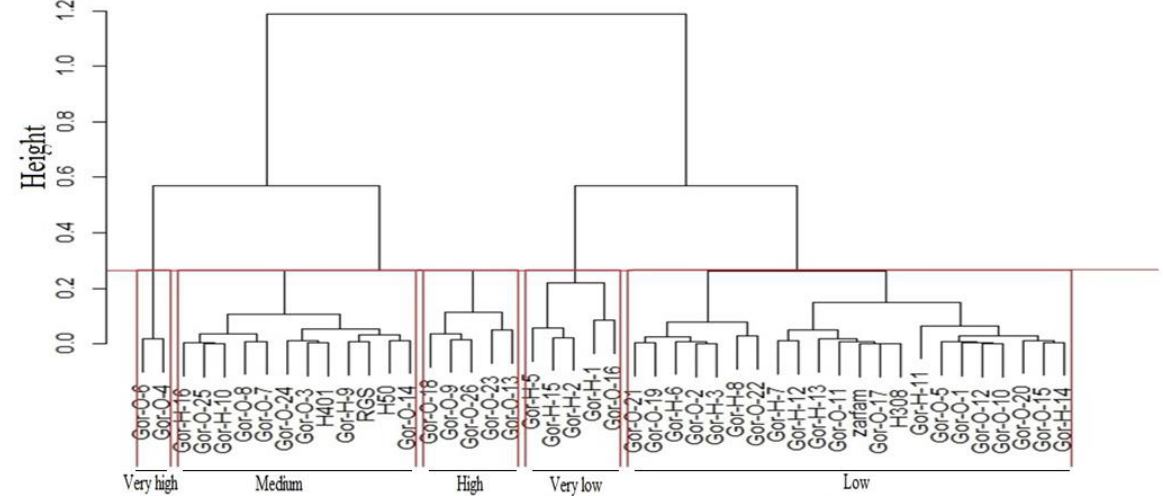
Fig. 5. Cluster analysis for the classification of 41 rapeseed lines and 5 cultivars based on assessing seed secondary dormancy by the HSDT